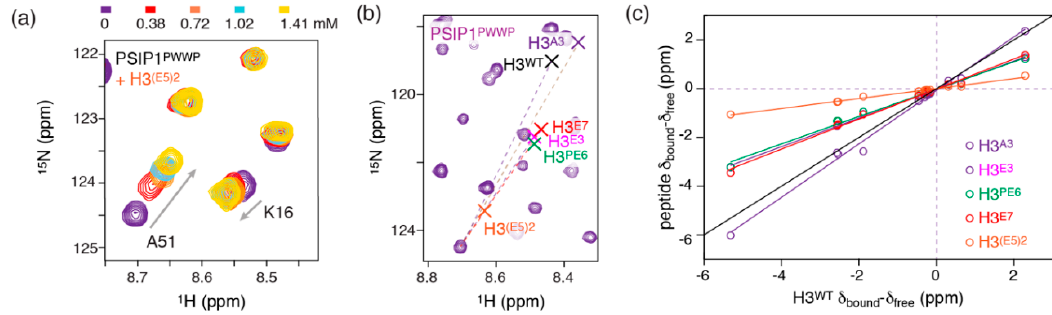
Figure 5. Altered binding mode for Glu-rich peptides binding to PSIP1 PWWP ( a ) Zoom on peak trajectories for A51 in the H3 (E5)2 titration. Color coding indicated. ( b ) Zoom on the 15 N-HSQC spectrum of unbound PSIP1 PWWP with the peak trajectory for A51 and the extrapolated bound-state peak position of A51 schematically indicated for all peptide substrates. ( c ) Comparison of the difference in free and bound chemical shifts ( δ bound – δ free ) for binding the H3 WT peptide and all peptide-models of this study. Bound-state chemical shifts are extrapolated from the observed CSPs based on the best-fits of the titration data. Black line indicates perfect correlation. Color coding indicated in the figure.